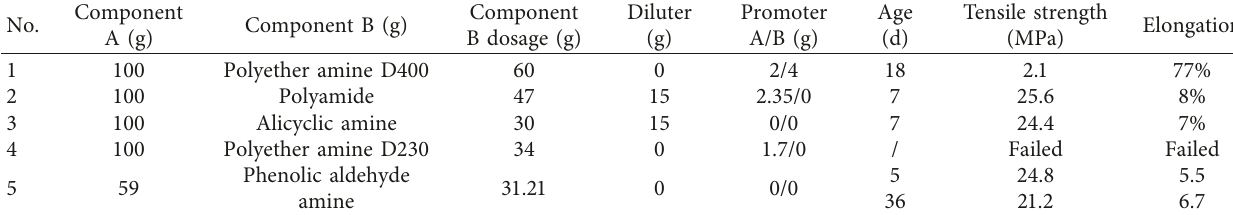
Table 1: Performance of different polyurethane-modified elastic epoxy.